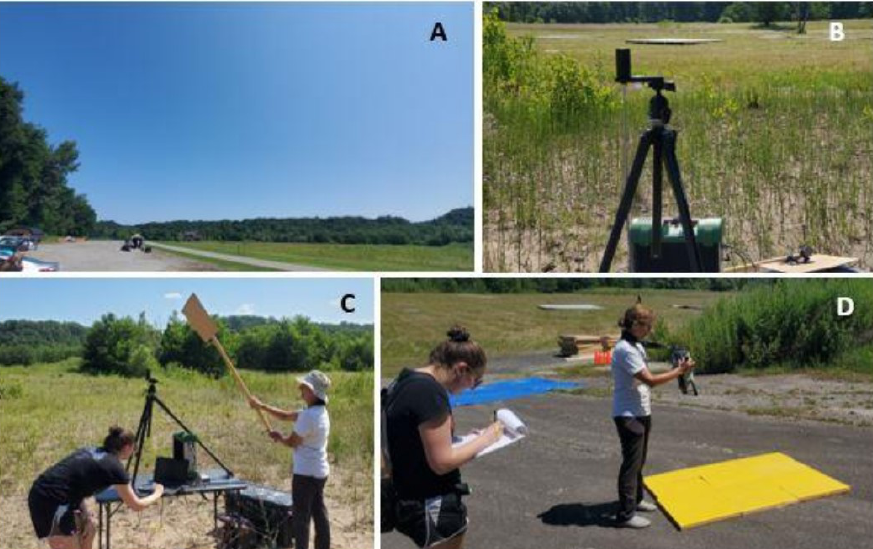
Figure 6. The experiment was conducted under clear and stable atmospheric conditions ( A ), with neg- ligible cloud cover and minimal aerosol loading. Data were collected using an ASD RCR irradiance spectrometer both ( B ) un-shaded and ( C ) shaded to separate direct and diffuse irradiance components. Ground reflectance measurements ( D ) of all major standards and targets in-scene were acquired using an SVC HR1024 field